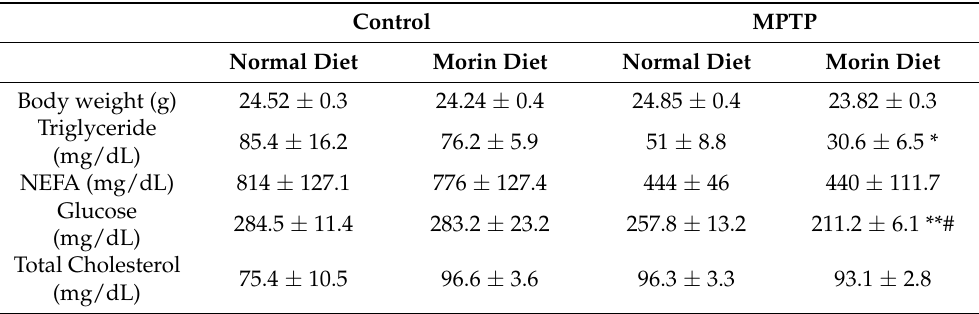
Table 1. Metabolic parameters of morin-fed mice. Data are represented as means ± SEMs. ** p < 0.01 and * p < 0.05 vs. control morin diet group, # p < 0.05 vs. MPTP normal diet